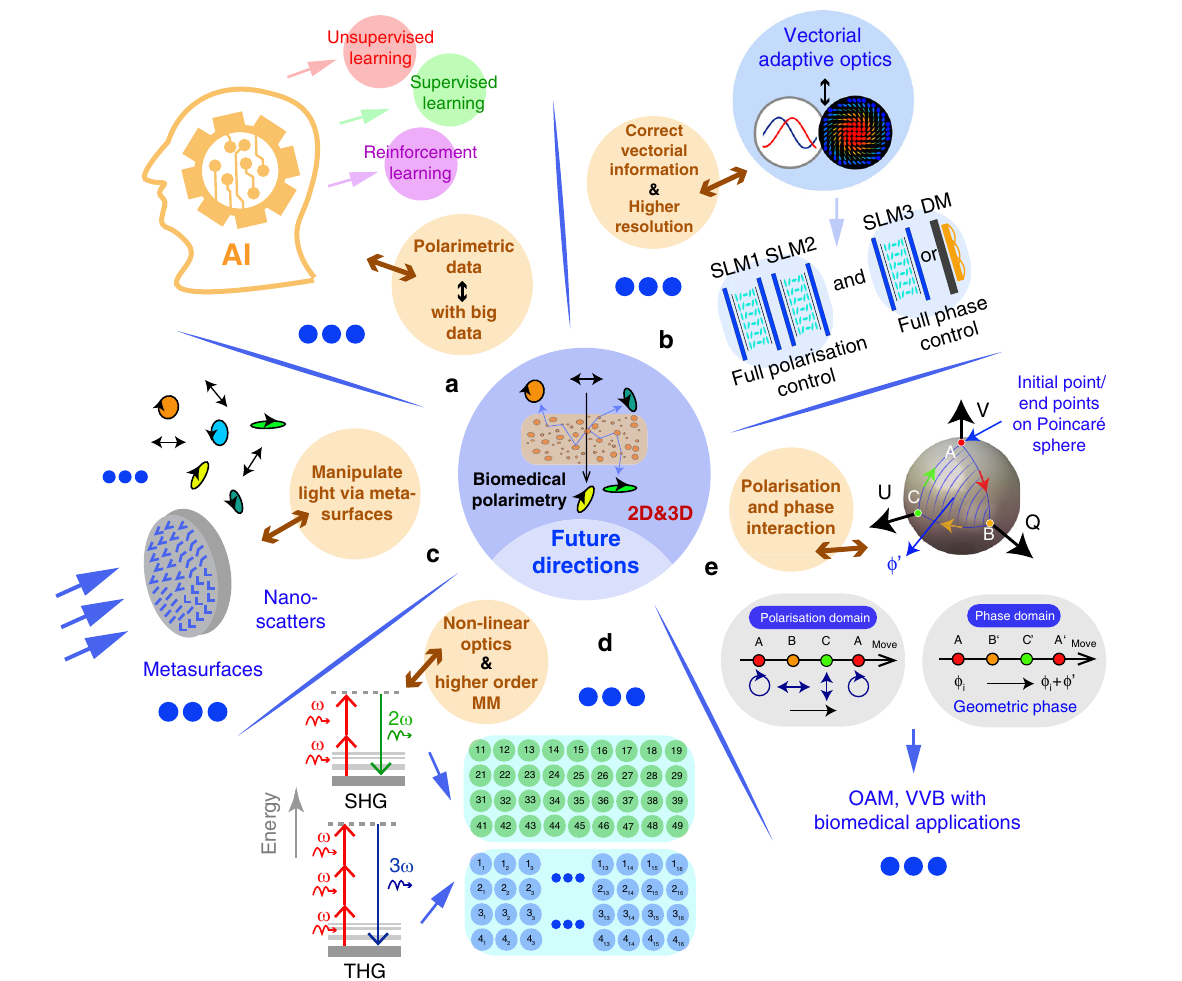
Fig. 8 Future directions for biomedical polarimetry. a Combination with machine learning techniques and big data. b Combination with vectorial adaptive optics. c Combination with metasurface based techniques. d Combination with nonlinear techniques, such as SHG and THG, in which a high order MM is required. e Combination with absolute phase information, such as geometric phase, with potential applications related with orbital angular momentum (OAM) and vector vortex beam (VVB)